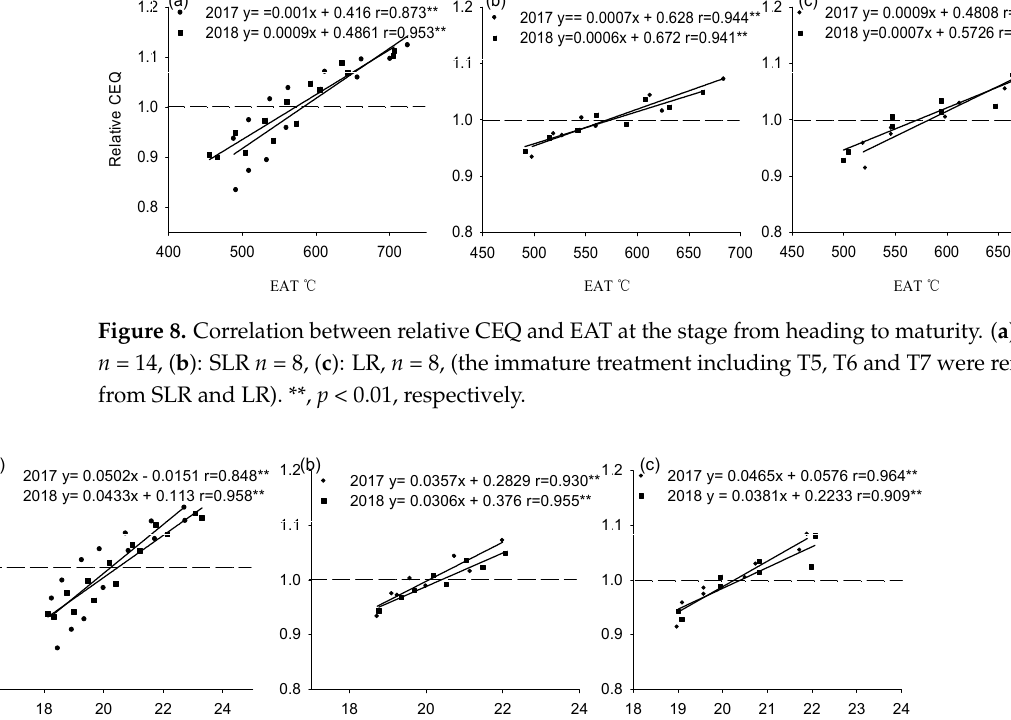
Table 9. The earliest suitable sowing date for SMR, SLR, and LR rice varieties to obtain high yield and good eating quality was May 15, and the latest optimal sowing dates for SMR, SLR, and LR were June 1, May 18, and May 20, respectively. Table 8. Characteristics of temperature in the grain filling stage for good eating quality rice (°C).